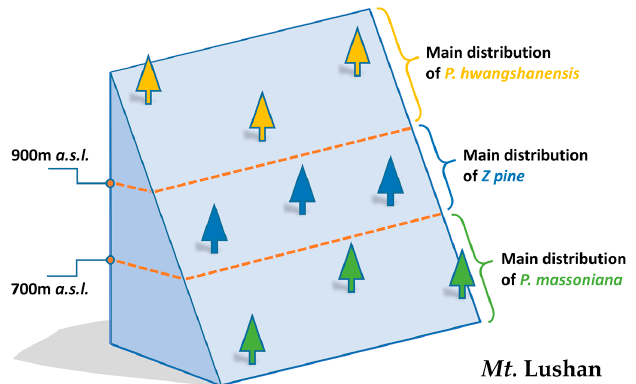
Figure 1. Schematic indicating the main distribution areas of P. massoniana , P.hwangshanensis ,